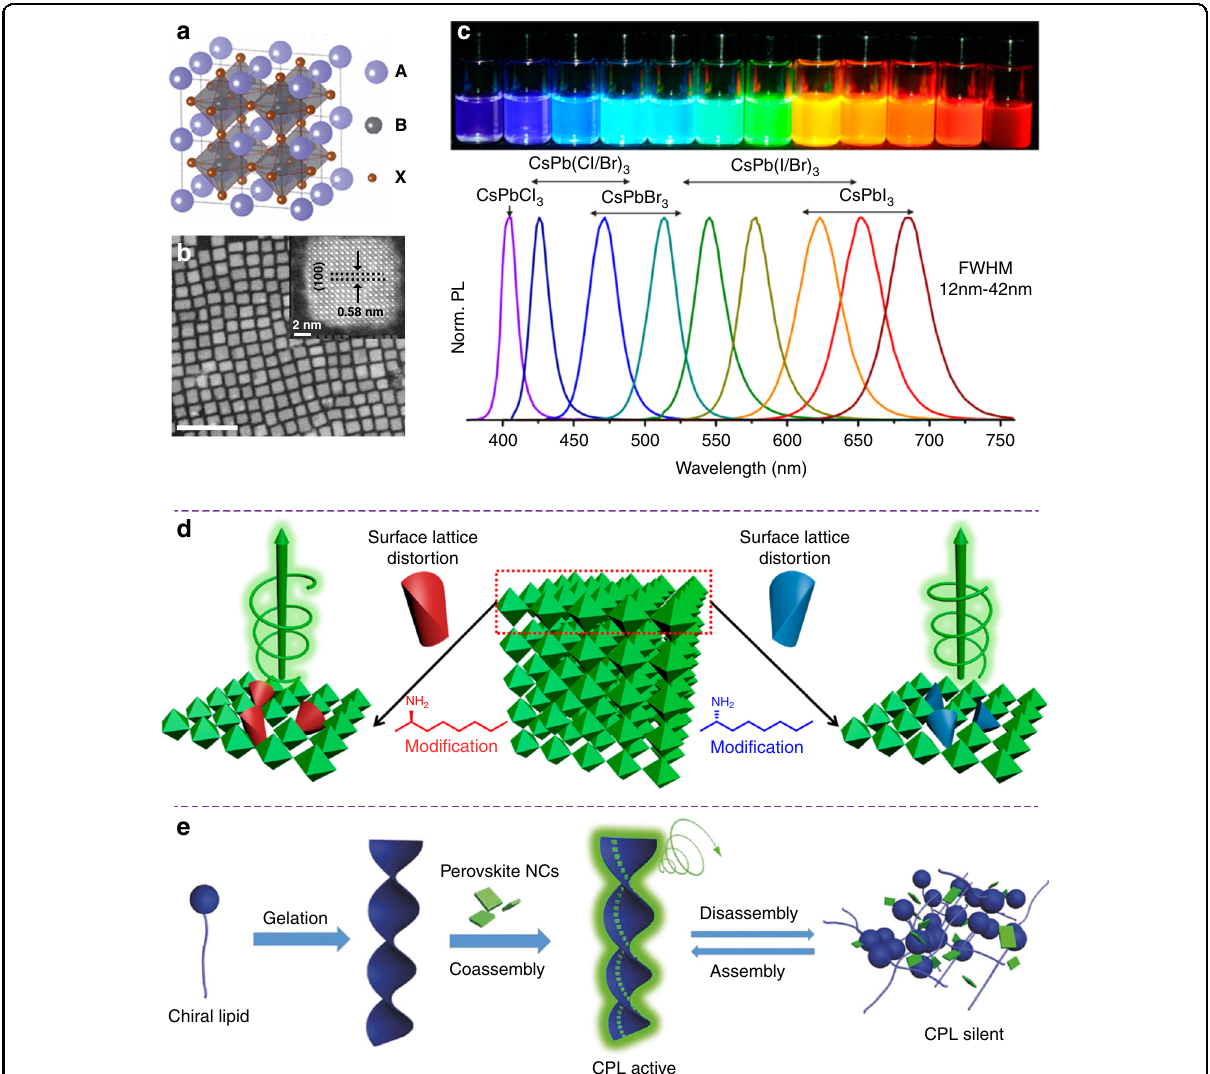
Fig. 9 Perovskite nanocrystals and circularly polarized luminescence. a Schematic structure of perovskite nanocrystals. Reproduced with permission from ref. 264 . Copyright 2015, American Chemical Society. b Typical TEM image of perovskite nanocrystals (Scale bar, 50 nm). Reproduced with permission from ref. 262 . Copyright 2020, Springer Nature. c Colloidal perovskite nanocrystals exhibiting tailorable photonic bandgap across the entire visible spectral region. Reproduced with permission from ref. 264 . Copyright 2015, American Chemical Society. d Chiral perovskite nanocrystals based on the chiral-ligand-assisted tip-sonication method. Reproduced with permission from ref. 268 . Copyright 2019, American Chemical Society. e Chiral perovskite nanocrystals based on supramolecular soft templates. Reproduced with permission from ref. 35 . Copyright 2018,